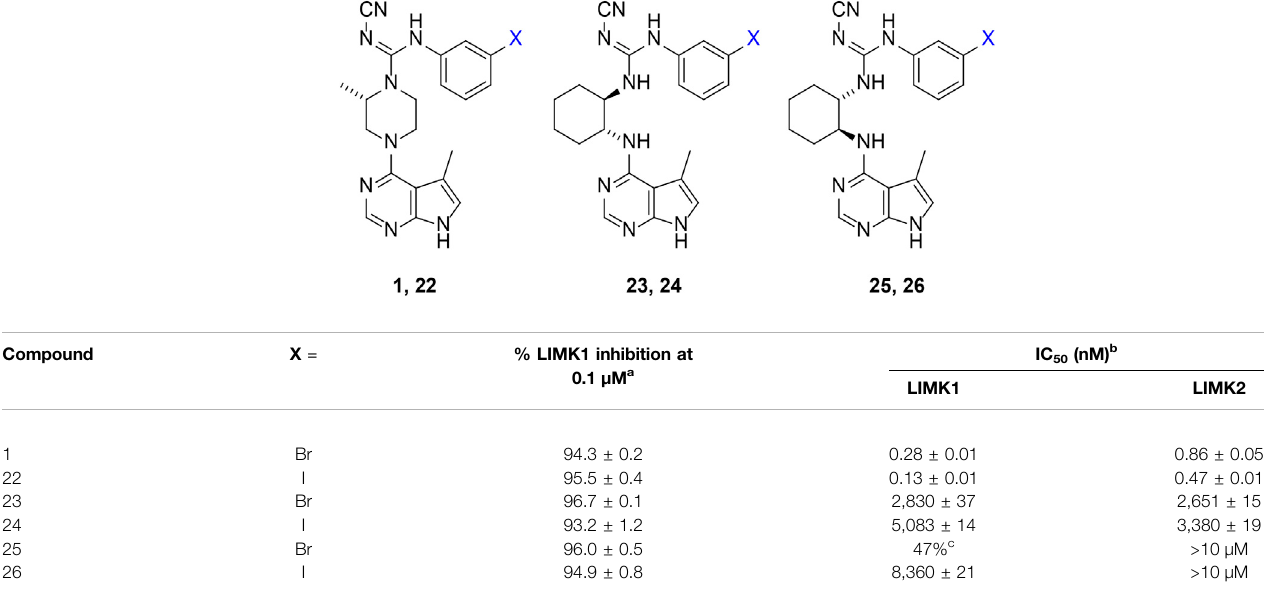
a Measured in Promega ADP-Glo ™ kinase Assay system. b Measured on the transfer of 33 P-labelled phosphate from ATP, to the kinase substrate (co fi lin) by Reaction Biology Corporation. c Inhibition at 10 μ